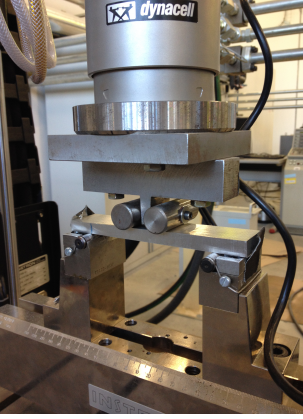
Figure 4. 4 points bending assembly.